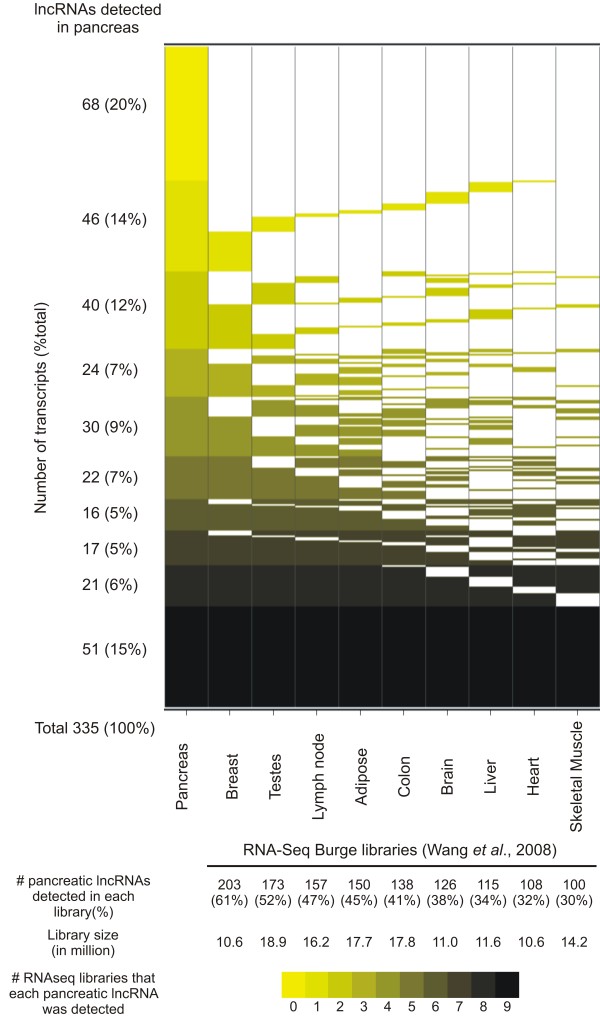
Intronic and intergenic lncRNAs detected in pancreatic tissues comprise both tissue-specific and broadly expressed transcripts. Genomic coordinates of 335 intronic/intergenic transcripts detected as expressed in pancreatic tissues were cross-referenced with genomic coordinates of transcripts detected in RNAseq libraries from nine different tissues [30]. LncRNAs were grouped and colored by the number of tissue libraries where their expression was detected (Y axis). RNAseq libraries are ordered in the × axis according to the number of pancreatic lncRNAs detected in each library.